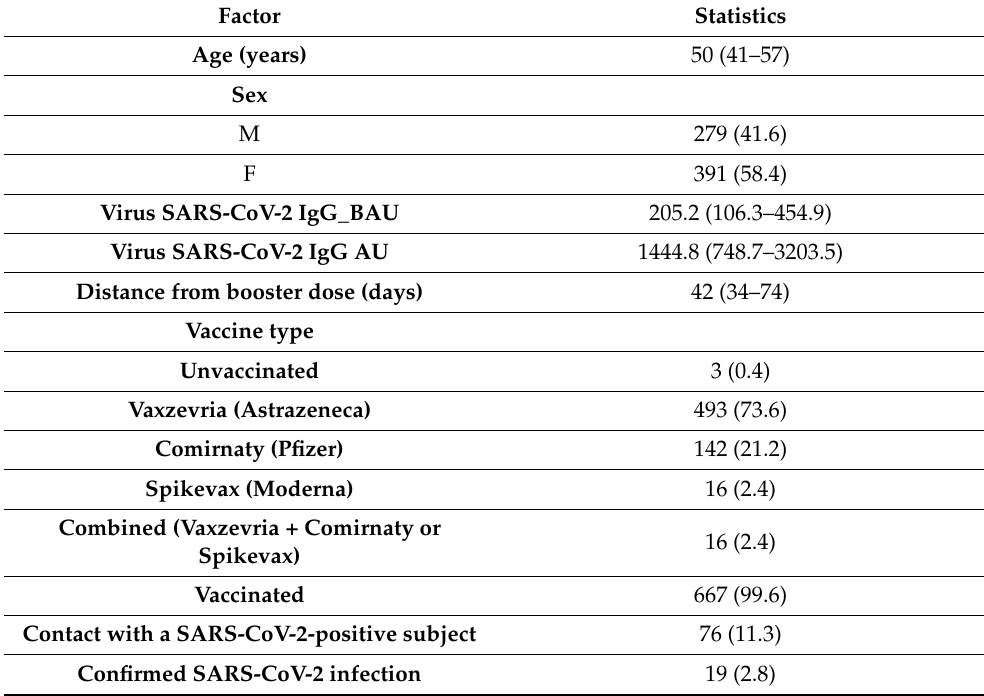
Table 1. Study population characteristics. Statistics: frequency (%) or median (interquartile